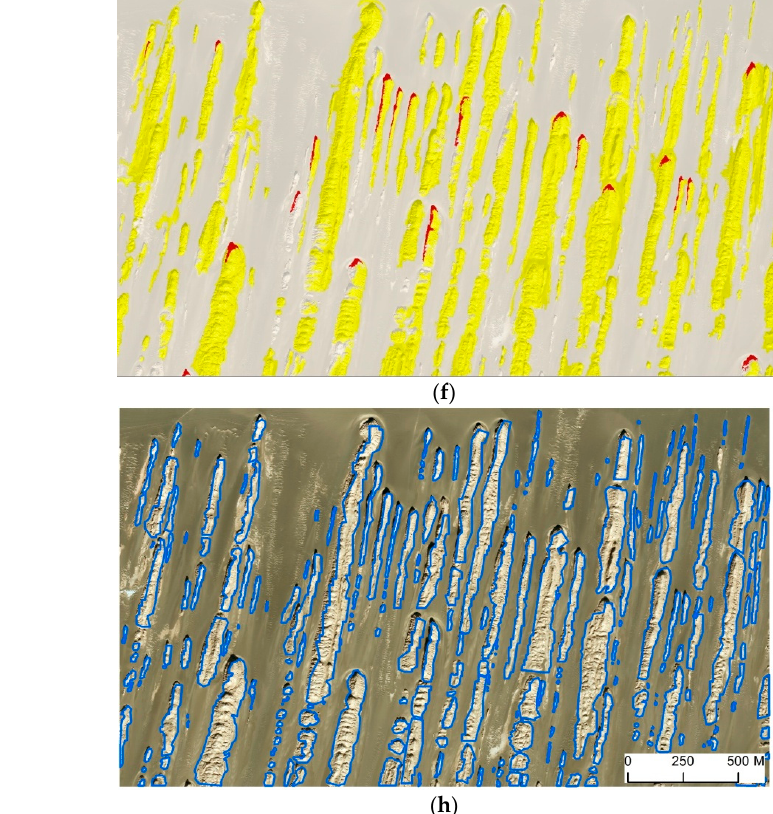
Figure 4. Classification results showing three classes, yardang ( yellow ), shadow ( red ), and corridor ( light grey ) using the two methods: ( a ) – ( g ) Object-based image analysis ( OBIA) method with different segmentation scales (SC) (( a ) SC=34, ( b ) SC=52, ( c ) SC=80, ( d ) SC=114, ( e ) SC=145, ( f ) SC=208, ( g ) SC=257),and ( h ) Edge detection result using the Canny edge detection (CED) method.